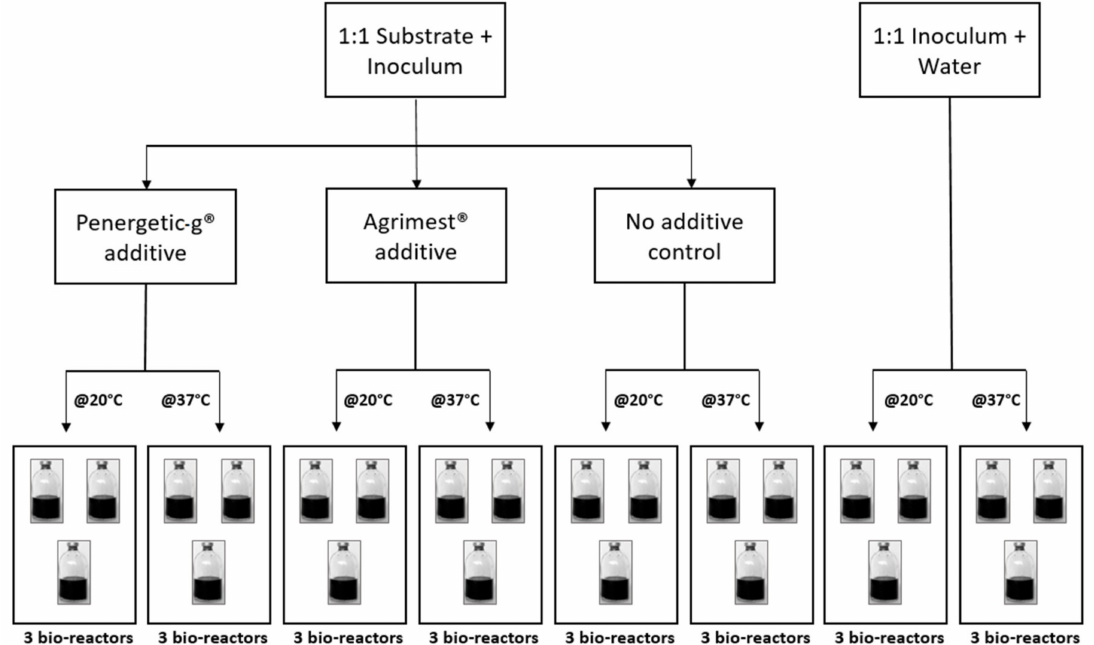
Figure 2. Biochemical methane potential (BMP) trial set-up with 24 bottles divided between two incubation temperatures, 20 ◦ C and 37 ◦ C. The substrate was liquid dairy manure. Each additive treatment, the manure control (no additive), and the inoculum control were done in